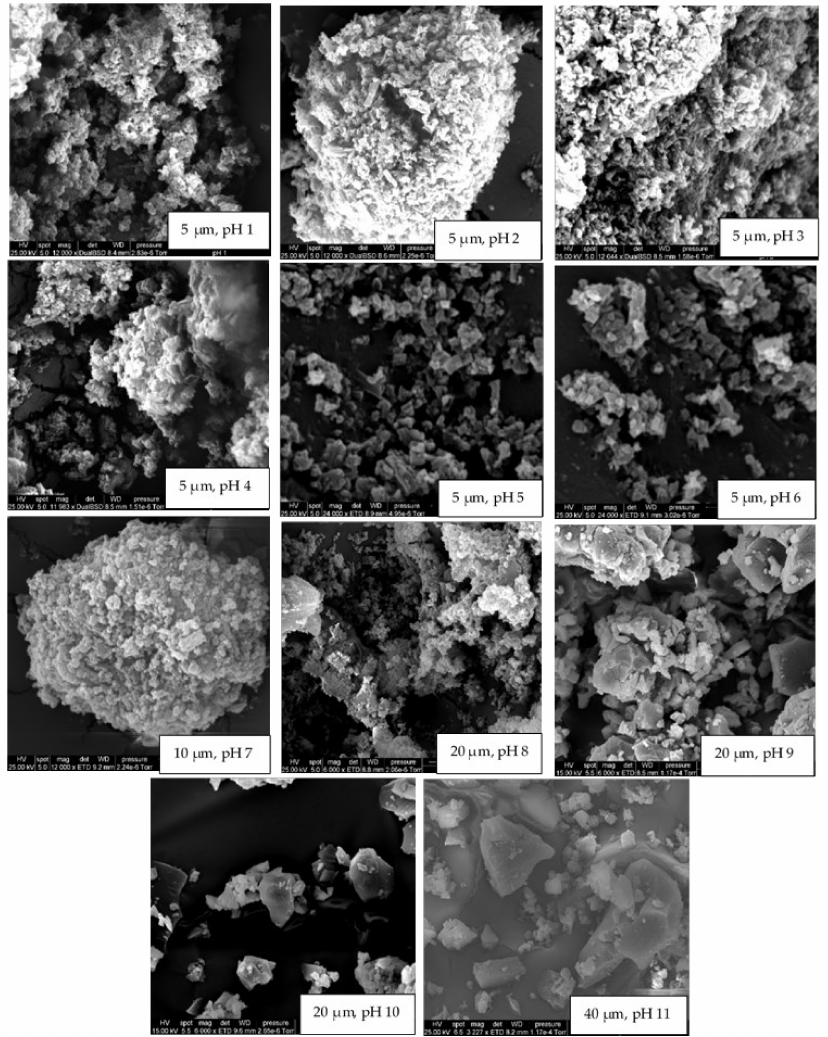
Figure 3. The effect of pH on the morphology (scanning electron micrographs) of rutin crystals grown under controlled humidity. pH values and scale bars can be found at the bottom of each